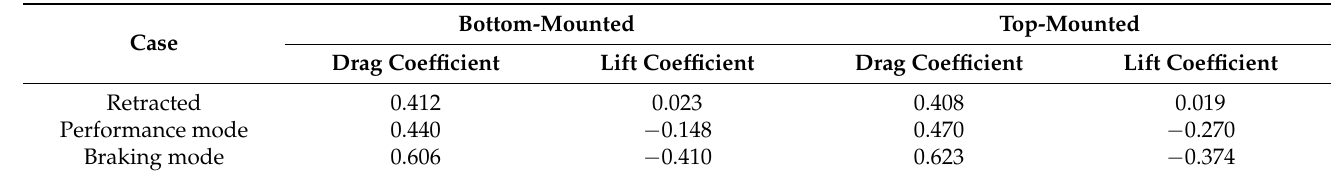
Table 1. Aerodynamic coefficients for the bottom and top rear wing